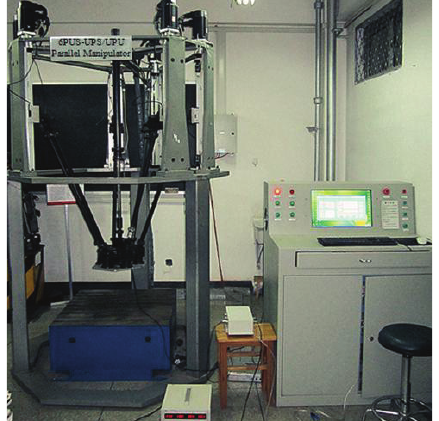
Figure 8: The prototype of 6PUS-UPU parallel